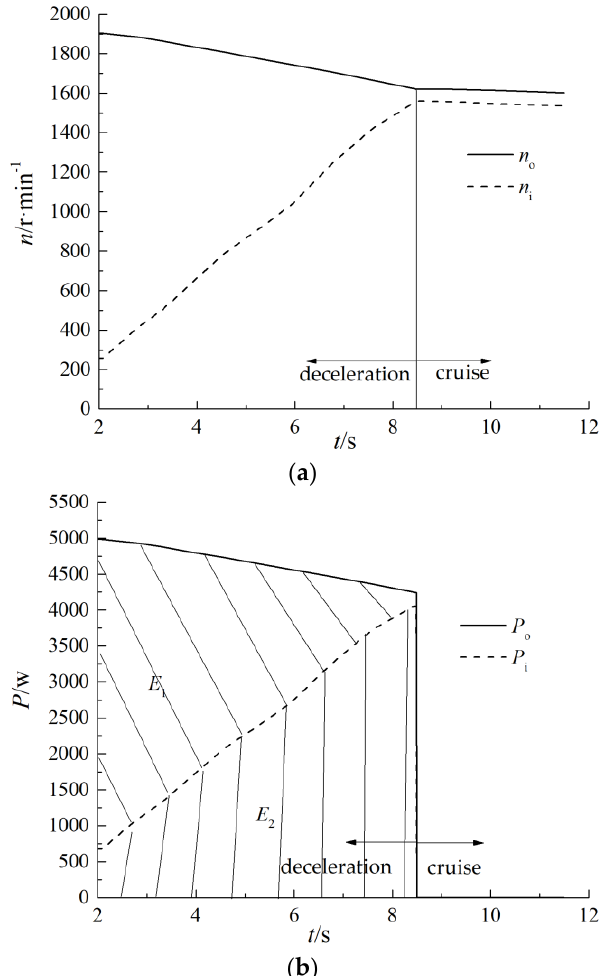
Figure 12. Experimental results of high power transmission: ( a ) electromagnetic coupler mechanical port speed; ( b ) electromagnetic coupler mechanical port power.